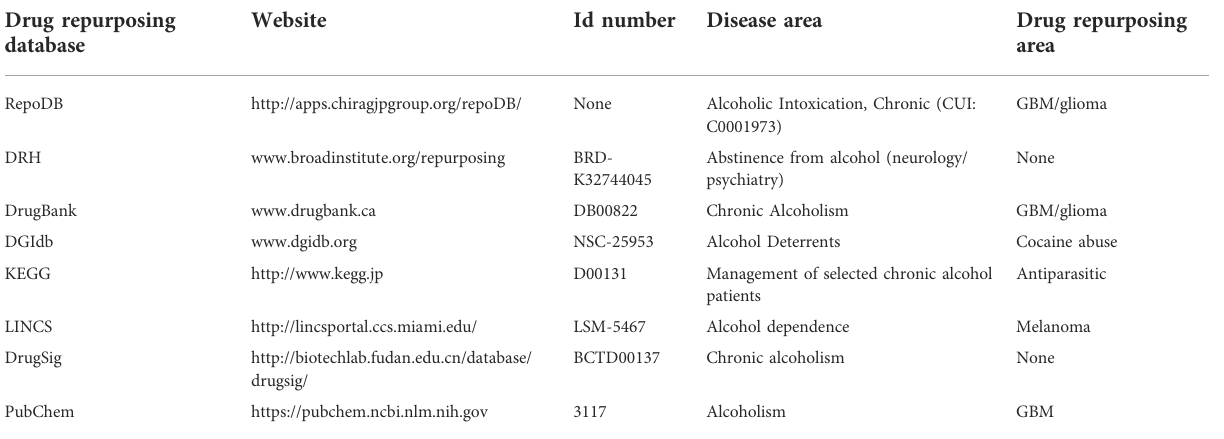
TABLE 1 The information on DSF in the drug repurposing